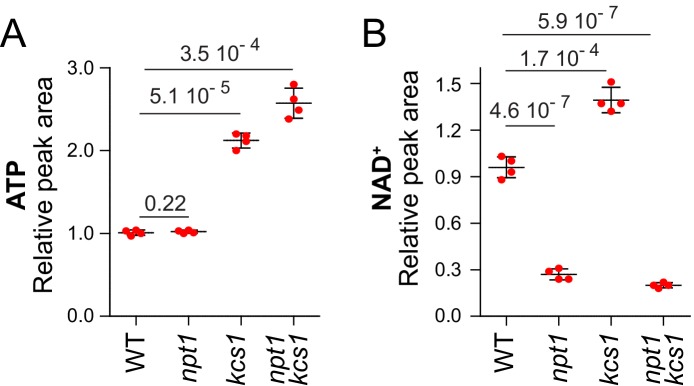
Stimulation of NAD+synthesis by ATP is abolished in npt1 mutants.(A–B) Wild-type (WT, Y286), npt1 (Y5581), kcs1 (Y2337), and kcs1 npt1 (Y11017) cells exponentially grown for 24 hr in SDcasaWAU medium. Quantifications (set at one for the amount measured in WT cells) were performed on independent metabolic extractions (N = 4). Error bars correspond to standard deviation and indicated p-values were calculated using a Welch’s t-test.10.7554/eLife.43808.026Figure 3—figure supplement 5—source data 1.Metabolic analyses for wild-type npt1, kcs1 and npt1 kcs1 mutant strains grown in the presence of adenine.